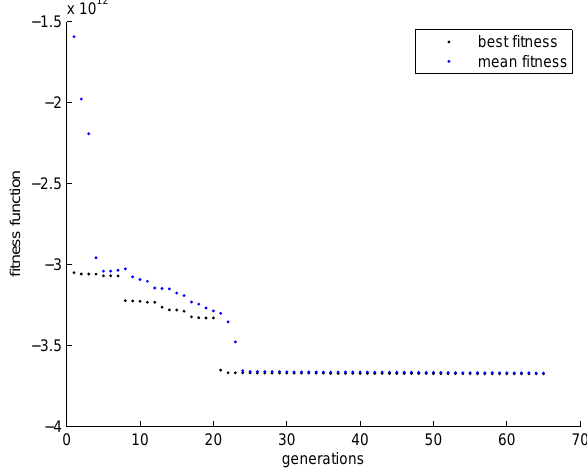
Figure 7: Convergence for the stiffness optimization problem of the